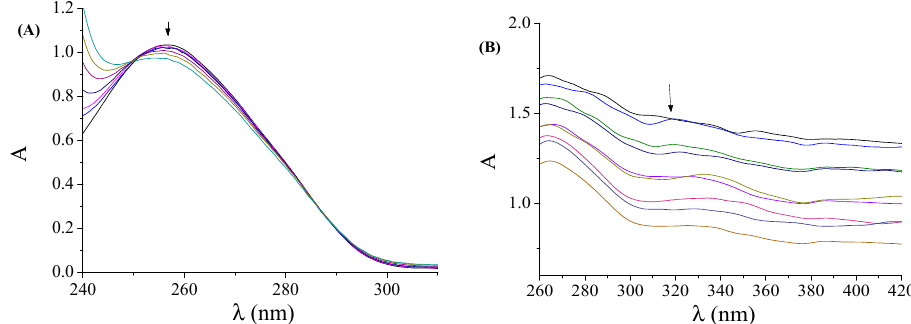
Figure 5. ( A ) UV–vis spectra of calf-thymus (CT) DNA (0.18 mM) in buffer solution (150 mM NaCl and 15 mM trisodium citrate at pH 7.0) in the absence or presence of increasing amounts of NL004 ( r = [NL004] / [DNA] = 0–0.5). The arrow shows the changes upon increasing amounts of NL004. ( B ) UV–vis spectra of NL004 in DMSO in the presence of increasing amounts of CT DNA ( r’ = [DNA] / [NL004] = 0–0.5). The arrow shows the changes upon increasing amounts of CT DNA. Table 3. Comparison of the spectroscopic data (changes of the UV-band, % of ethidium bromide (EB)–DNA fluorescence quenching), the quenching and the binding constants of NL004 and free NAP for CT DNA (K b ) and competitive studies with EB (Ksv, k q